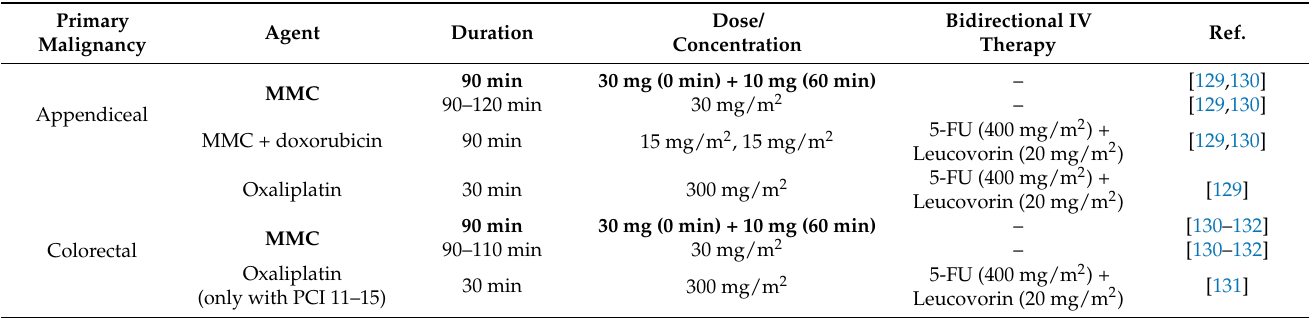
Table 1. Recommended HIPEC Regimens for Appendiceal and Colorectal Cancers in the US. The most common established regimens across societies are shown and first-line recommendations